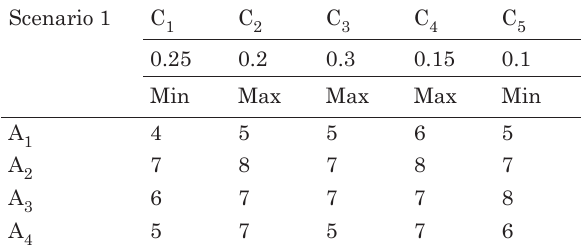
Table 1. decision-making matrix for the first